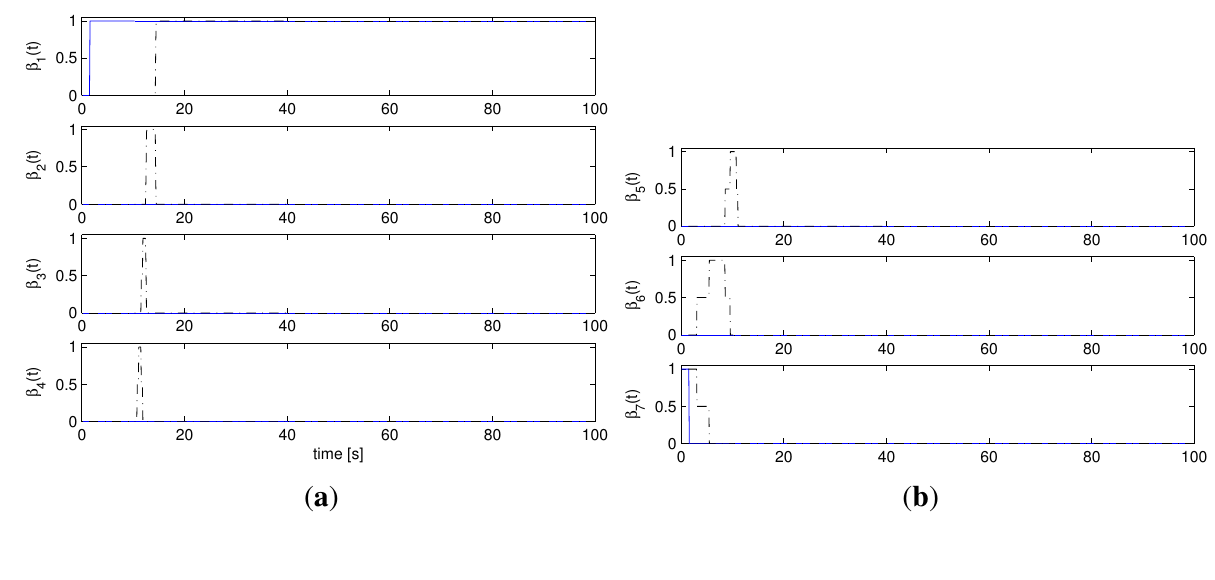
Figure 7. Unmodeled dynamics, θ ∗ = 0 . 5 : AMC controller weights β ( t ) : Multi-AMC (solid), AMC (dash-dotted). (Note that, for both schemes, all the controller weights from β to β are zero for all t ≥ 0 ). ( a ) β 4